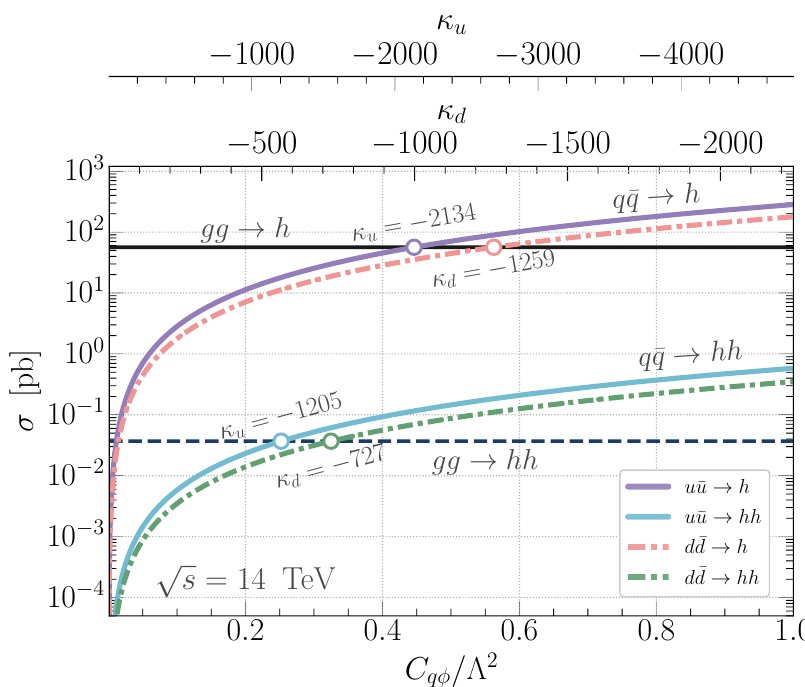
Figure 1 . The production cross-section of single Higgs and di-Higgs at 14 TeV from the quark anti-quark annihilation q ¯ qhh as a function of the Wilson coefficients C Λ 2 and C Λ 2 versus uφ / dφ / the SM gluon fusion cross-sections (the horizontal solid lines for gg → h and gg → hh ). One can observe that for values of κ = − 1205 ( − 2134) and κ = − 727 ( − 1205) the q ¯ qhh channels become u d the dominant di-Higgs (single Higgs) production